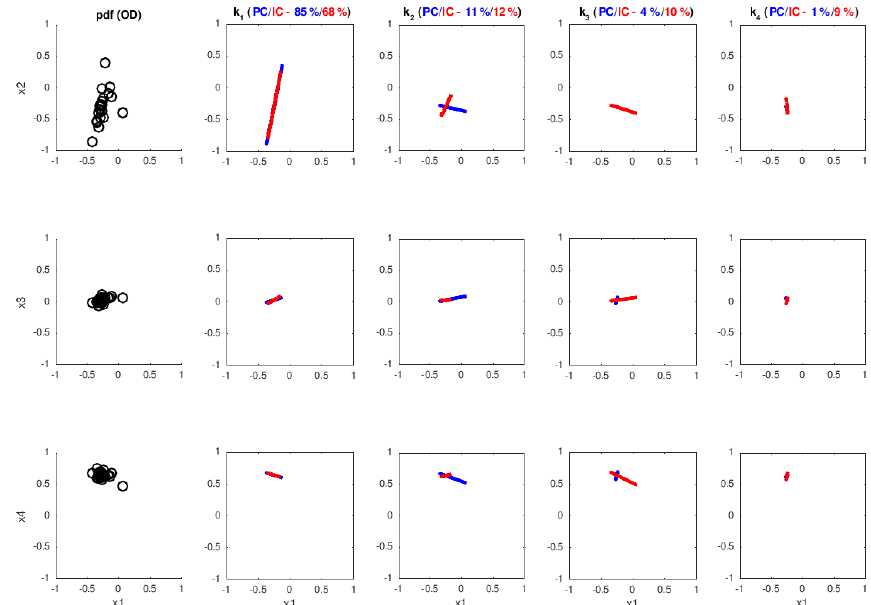
Figure 17. PCA (blue) and ICA (red) applied to the H > 0 . 4 regions of an example of the RHI from the event considered in the inter-radar comparison in Sect. 3.1 (MXPol X-band data).